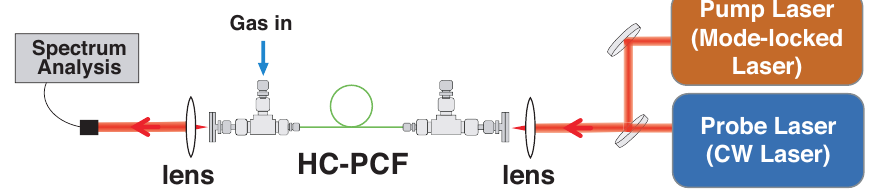
Figure 1. Experimental apparatus assumed in the theoretical